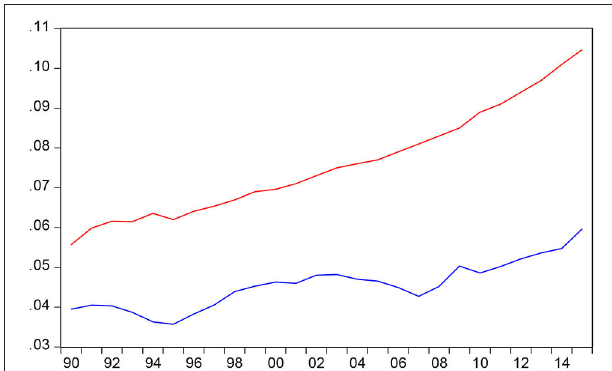
FIGURE 1 | Plots of OLDR (65 years old ratio) and health expenditure over (HER GDP